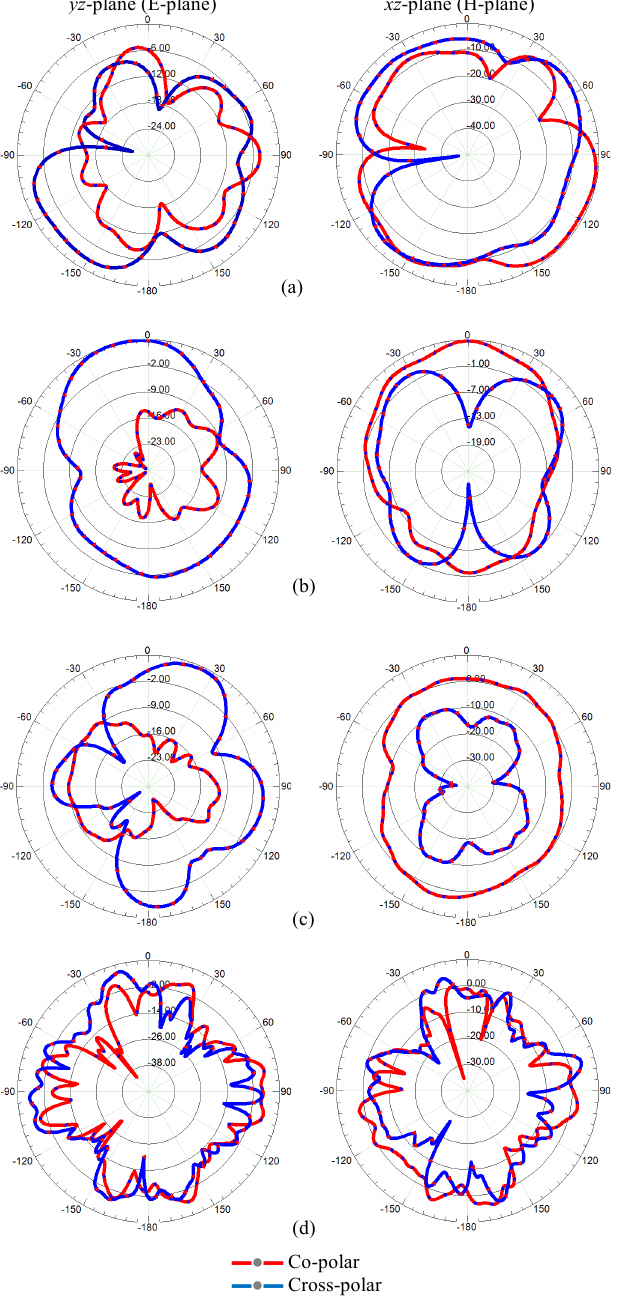
Figure 10: Simulated radiation patterns at frequencies (a) 5, (b) 10, (c) 16, and (d) 24 GHz.